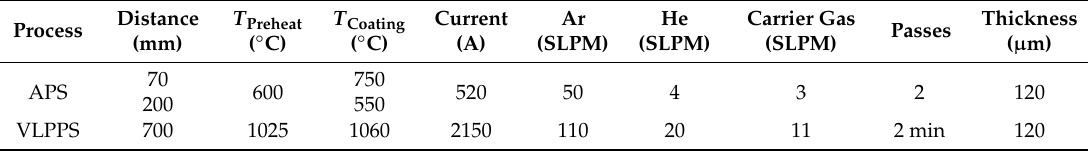
Table 1. Used coating parameters for the production of YAlO 3